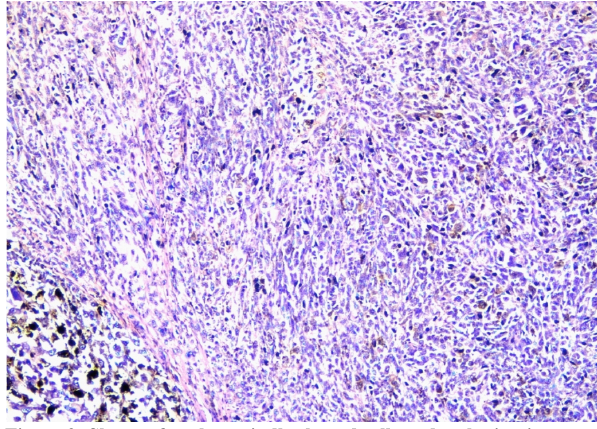
Figure 2: Sheets of oval to spindle shaped cells and melanin pig- ments. (H E stain, x 100)